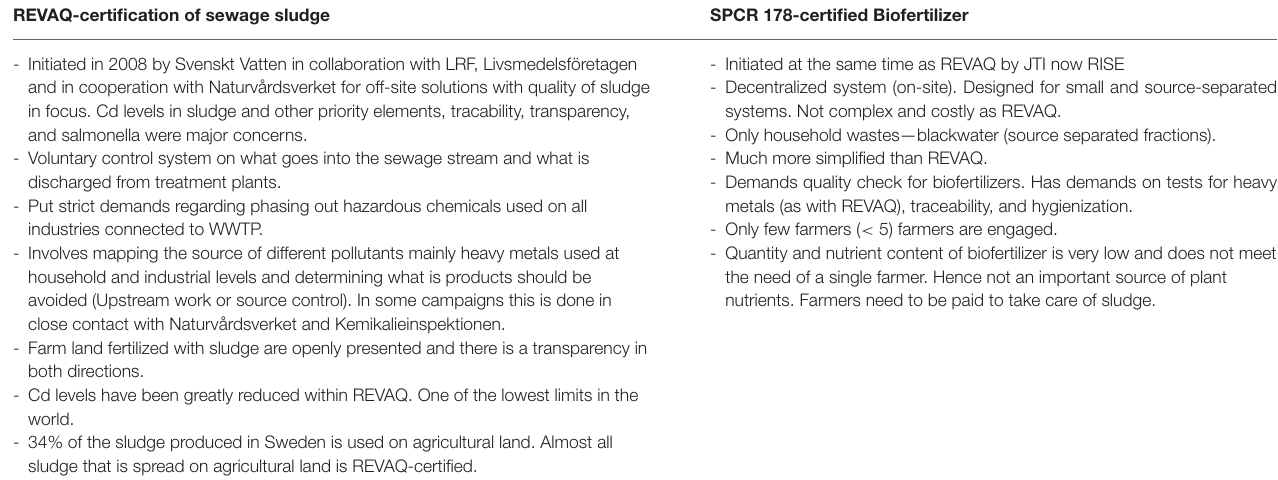
TABLE 2 | REVAQ and SPCR 178